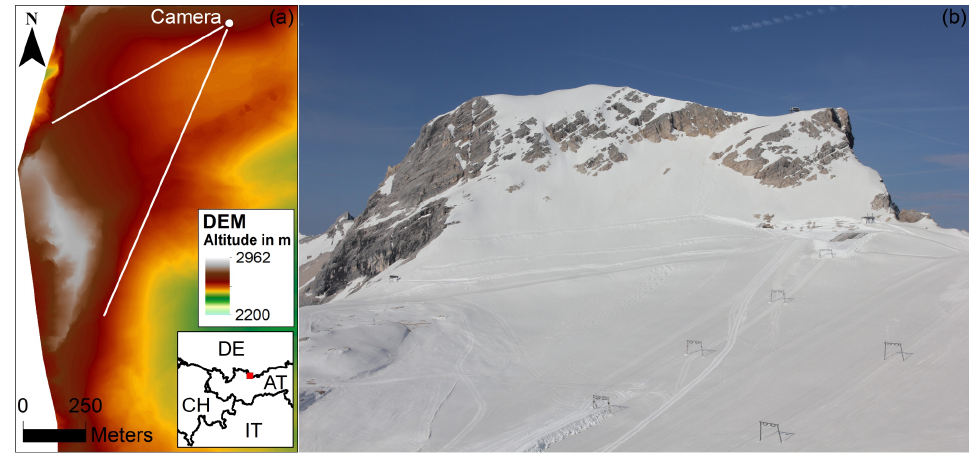
Fig. 1. (a) The test site of PRACTISE is located at the Schneefernerkopf which is situated in southern Germany, at the border to Austria (right frame). The DEM depicts the camera location and the field of view of the camera. (b) The installed digital camera system records hourly photographs of the investigation area, the north-eastern slope of the Schneefernerkopf summit (upper central area).